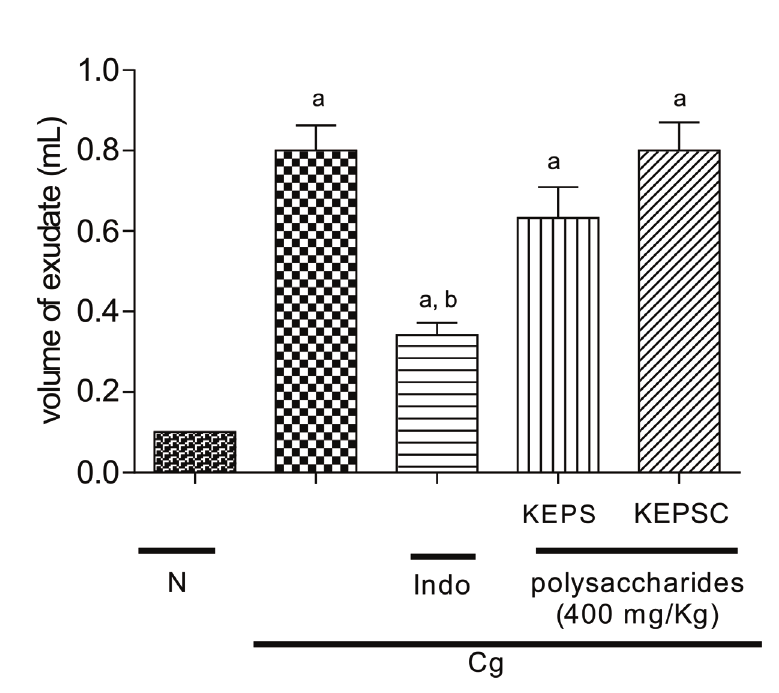
FIGURE 2 - KEPS and KEPSC effects on the volume of pleural inflammatory exudate. The pleurisy was induced by intrapleural carrageenan injection (Cg - 200 µg/cavity) in rats (n = 6-7), 1 h following oral administration of the EPS at 400 mg/kg or saline (Cg). Indomethacin (Indo, 5 mg/kg) was orally administered as an anti-inflammatory reference drug (positive control). N = normal animals that received no pleural injection of carrageenan. Each point represents the mean ± standard error of the mean of volume of exudate 4 h after injection of carrageenan. a p < 0.05 when compared with normal rats; b p < 0.05 when compared with group of rats injected with carrageenan and untreated (Cg) (ANOVA, Tukey’s test).